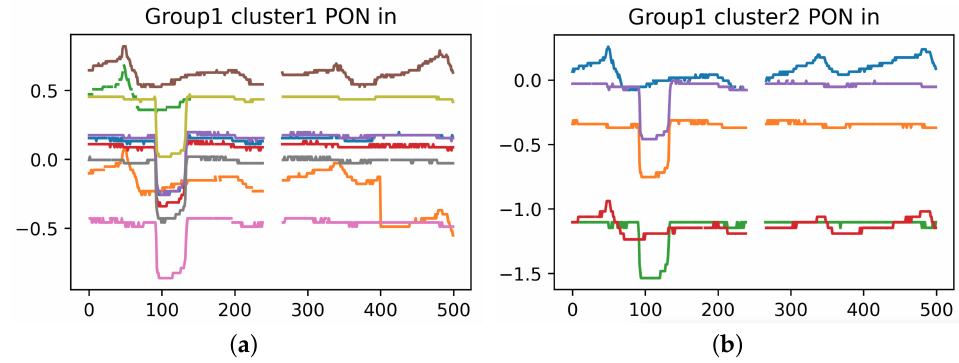
Figure 11. Waveforms of OLT 1. The vertical axis represents the optical power. The horizontal axis represents the sampling point, which is sampled every 10 min. Each subplot shows the situation of one secondary splitter, and curves of different colors reflect the waveforms of different ONUs under the same secondary splitter. Similarity of two waveforms indicates that the two ONUs are suffering the same perturbation. ( a ) Secondary Splitter 1. ( b ) Secondary Splitter